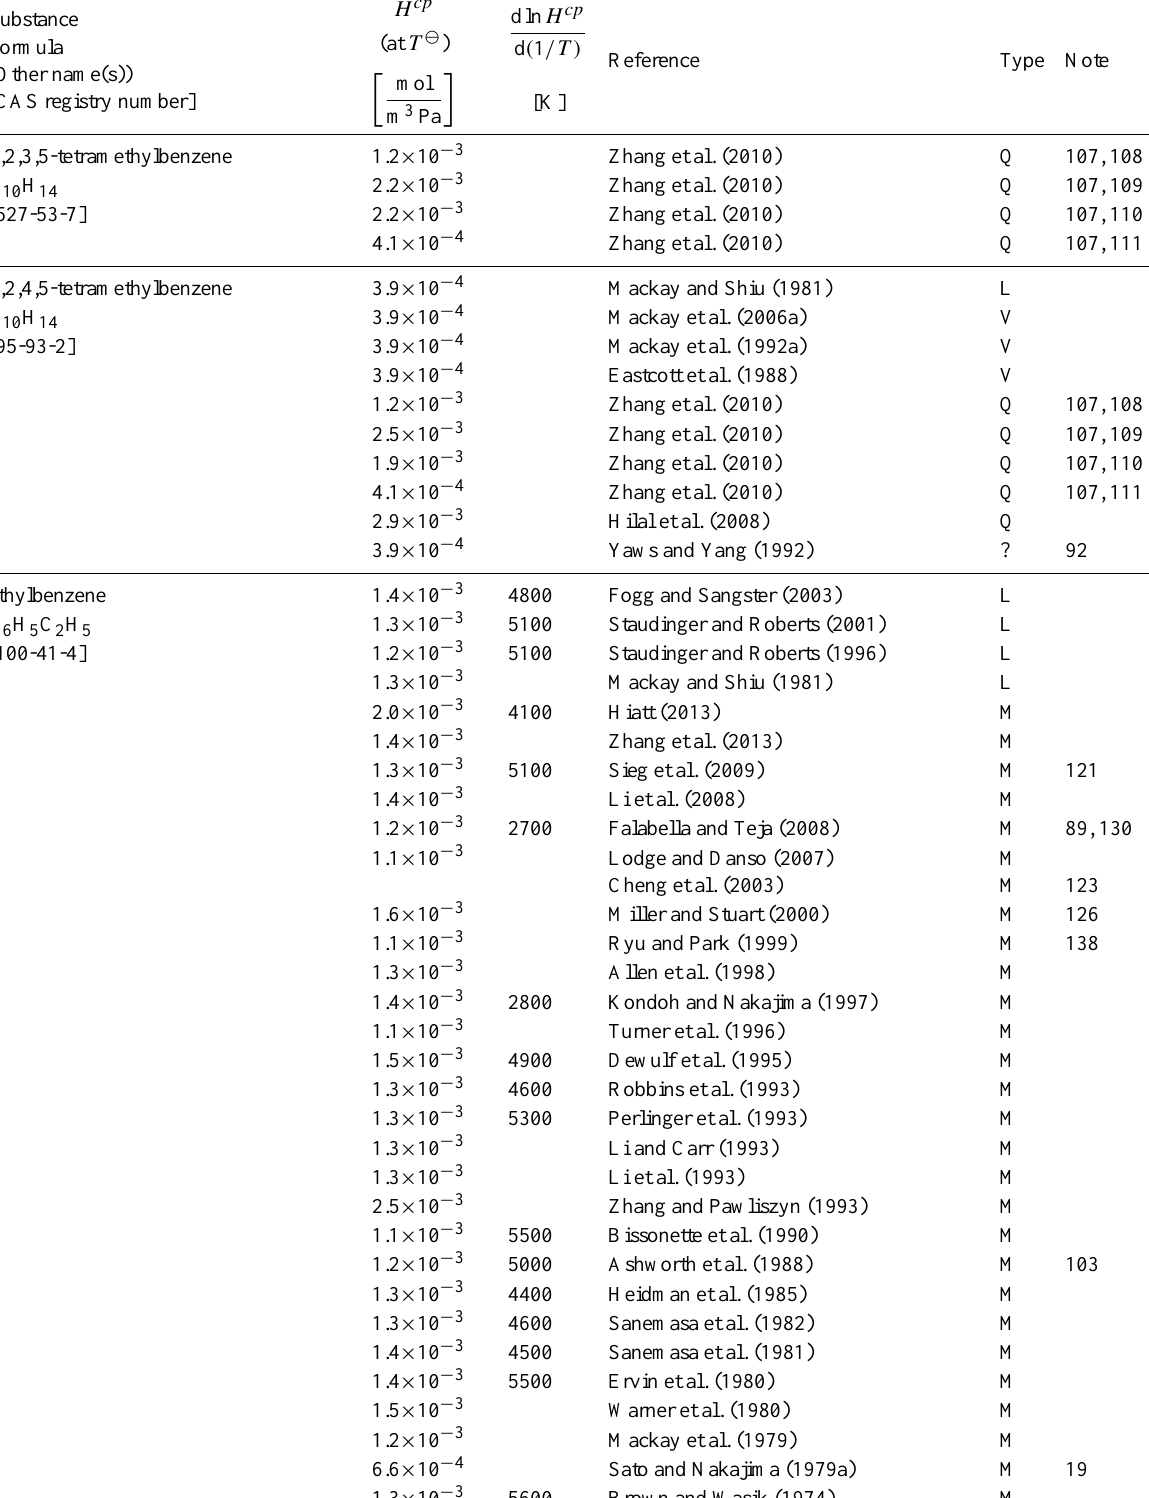
Table 6: Henry’s law constants for water as solvent